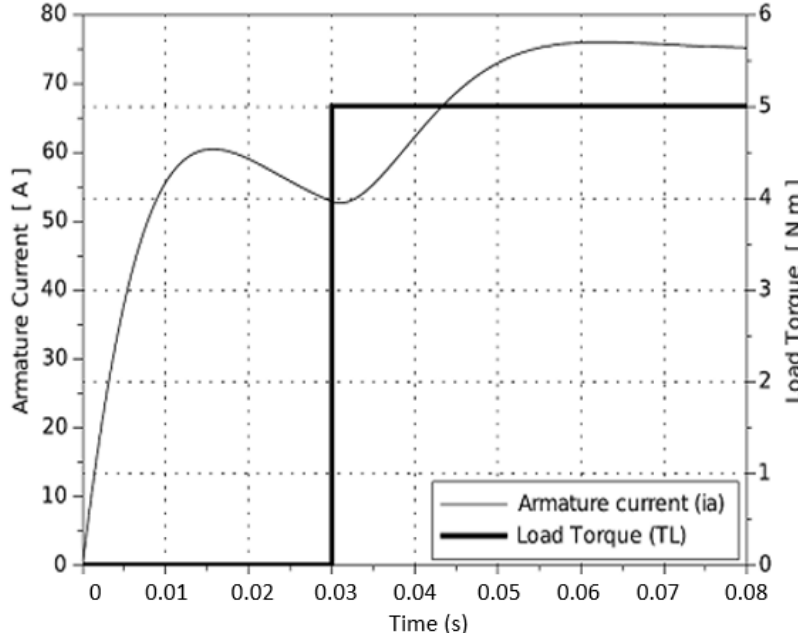
Figure 15. Load test results in Scilab for i a ( t ) , with a load torque = 5 Nm.